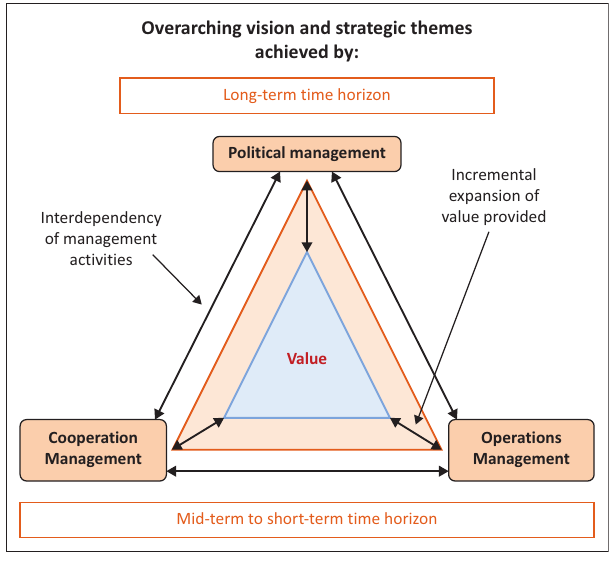
FIGURE 2: Value creation by using the strategic